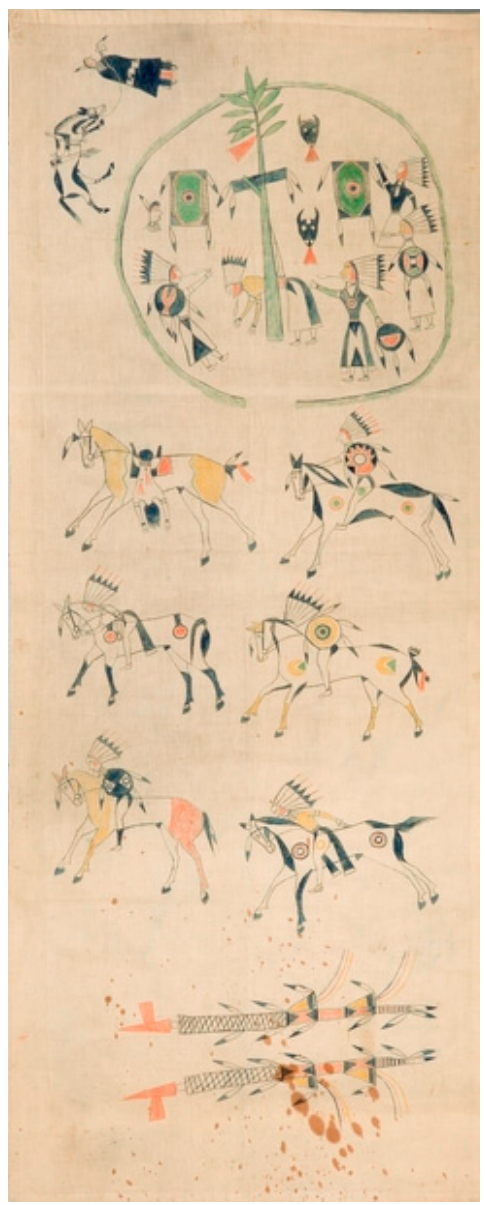
Figure 8. Painting on Muslin. Attributed to Siyosapa (Hunkpapa/Yanktonai), unknown collection date. Cotton muslin, paint, ink, 216.4 cm × 85 cm. Used by permission of National Museum of the American Indian (023304). Photo by NMAI Photo Services.